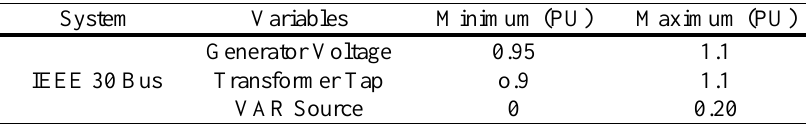
Table 4. Constraints of control variables.